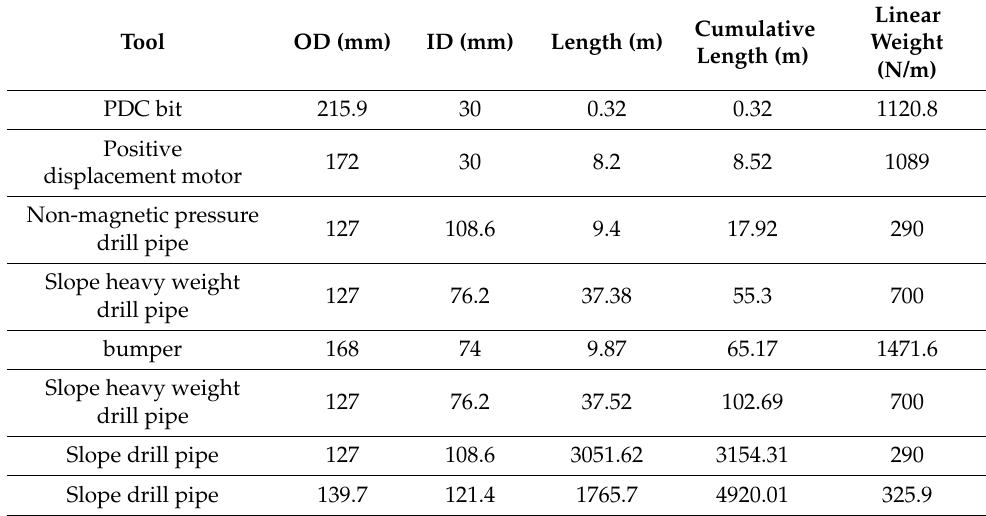
Table 2. Current bottom hole assembly (BHA) for well M open hole.